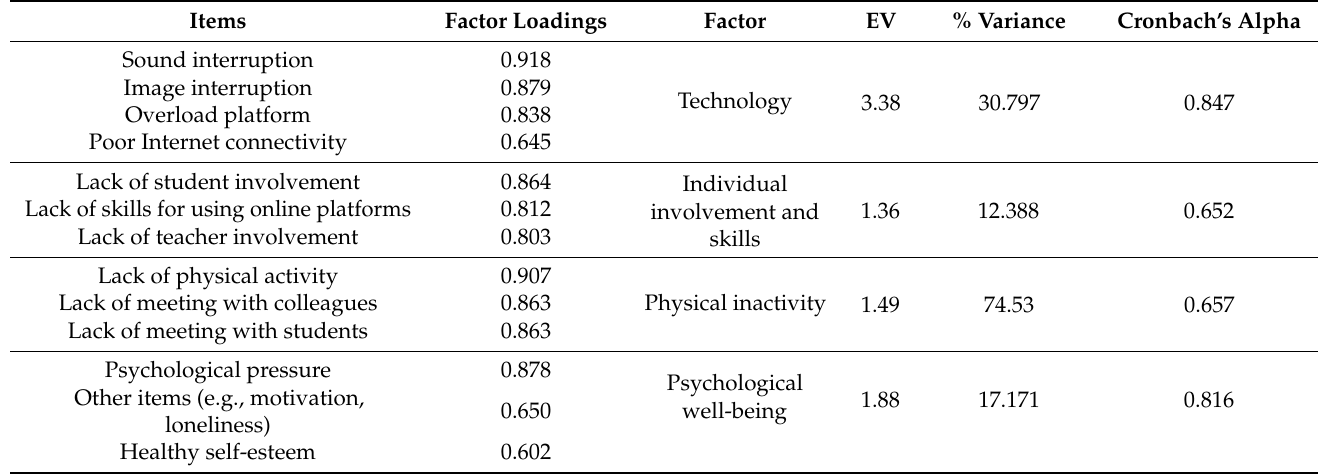
Table 5. Testing data from the teachers’